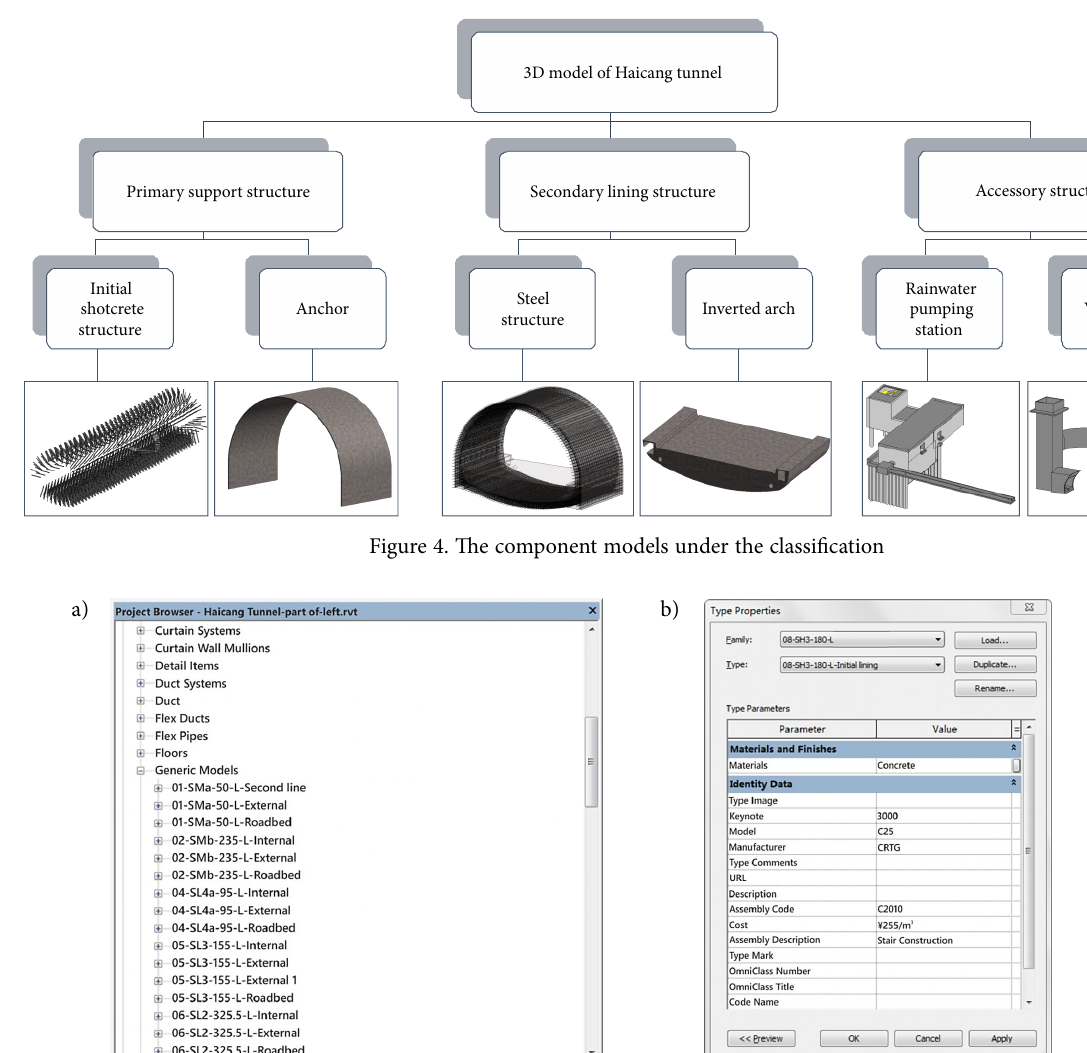
Figure 3. The method of establishing a component model